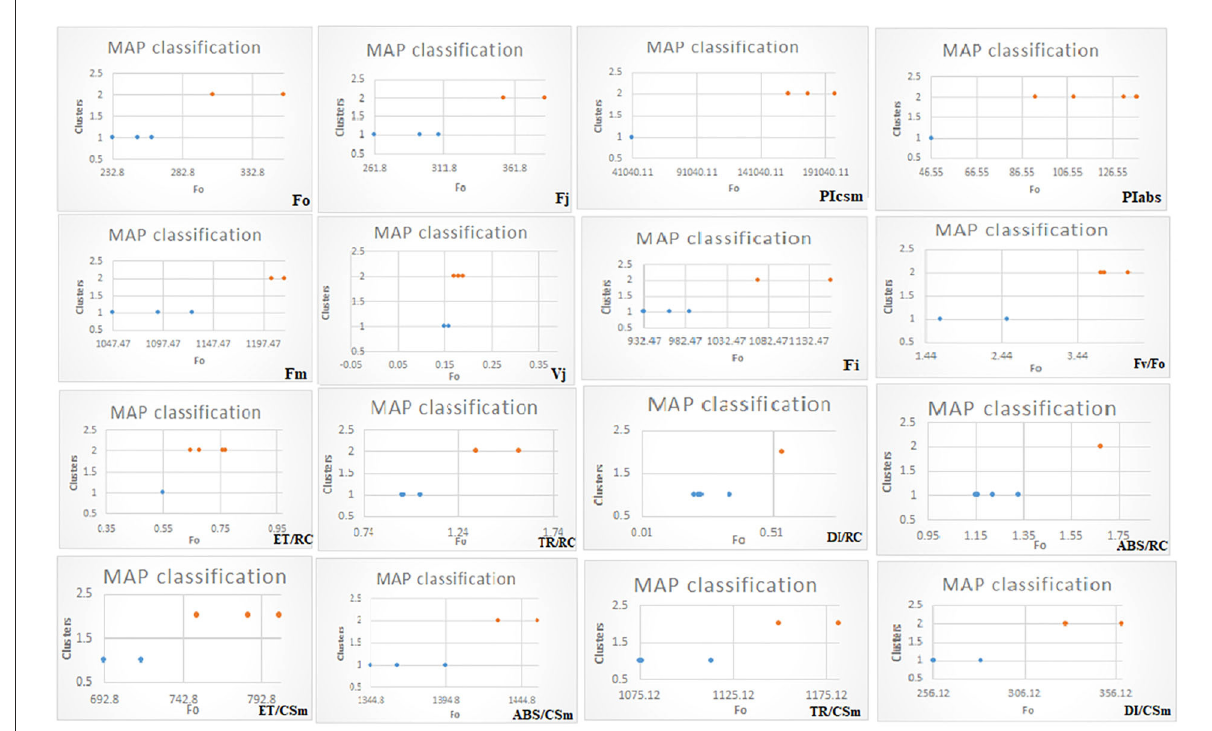
FIGURE10 MAP classification model of G-mean clustering of different chlorophyll fluorescence